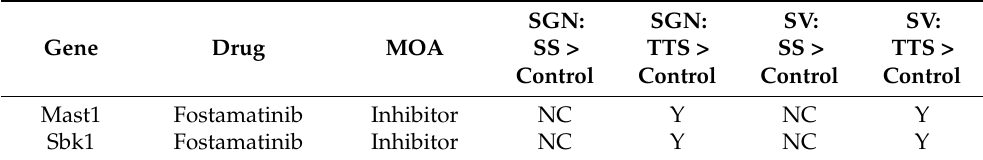
SV: SV: SGN: SGN: TTS > SS > TTS > SS > Control Control Control Control